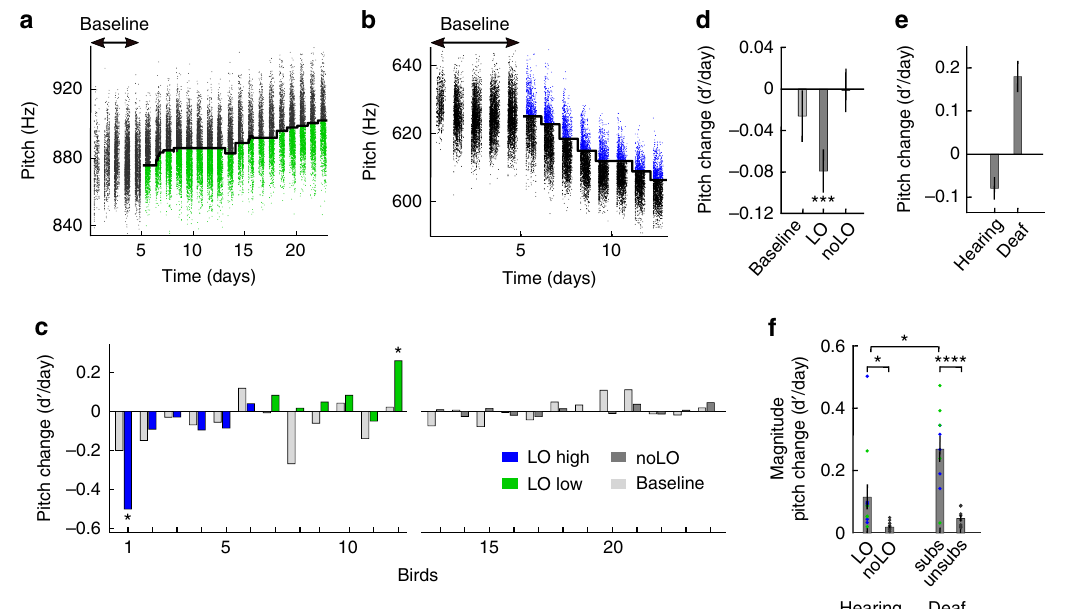
Fig. 2 In hearing birds, the valence of light-off reinforcers is negative. a , b Hearing birds change pitch in the direction of decreasing LO rate, here shown for a low-pitch light-off (LO low) bird (bird b2y2, a same bird as in Fig. 1c, d) and a LO high bird (bird p6s6, b ). Legend as in Fig. 1d, f. c Histograms of average daily pitch changes in LO high (blue, n = 6), LO low (green, n = 6), and in hearing control (noLO) birds (gray, n = 12). The asterisks indicate subs birds with signi fi cant pitch changes compared to controls (two-sample, two-sided t -test, p < 0.05, see “ Methods ” ). d The three mixed linear fi xed effect terms and their standard errors. The bars indicate the daily change in pitch (d ’ /day) during baseline, during LO exposure in the direction of increasing LO rate (LO, ***indicates non-zero fi xed effect − 0.08, p = 1.4 × 10 − 4 , df = 377, SE = 0.02, tstat = − 3.85, con fi dence interval − 0.12 to − 0.04 d ’ /day, n = 24 birds), and in hearing control birds (noLO). e Average directed pitch changes over all days in LO (hearing, 144 days) vs subs (deaf, 102 days) birds. Hearing birds changed their pitch away from the LO zone (decreasing the number of renditions with LO) and deaf birds towards the LO zone (increasing the number of renditions with LO). The error bars indicate the standard errors of the mean. f The magnitude of average pitch change is larger in subs birds than in LO birds (0.16 d ’ /day, *indicates p = 0.01 for average magnitude, tstat = 2.73, df = 20, two-sample two-sided t -test, n = 12 LO and n = 10 subs birds), and much larger than in unsubs birds (0.22d ’ /day in time-matched periods, **** indicates p = 4 × 10 − 5 , tstat = − 5.35, df = 18, n = 20 birds, two-sample two-tailed t -test). The magnitude of average pitch change is larger by 0.10 d ’ /day for hearing LO than noLO birds ( p = 0.02, tstat = − 2.43, df = 22, two- sample two-tailed t -test, p -values are not adjusted for multiple comparisons. The error bars indicate standard errors of the mean and the dots represent individual birds (colors as in